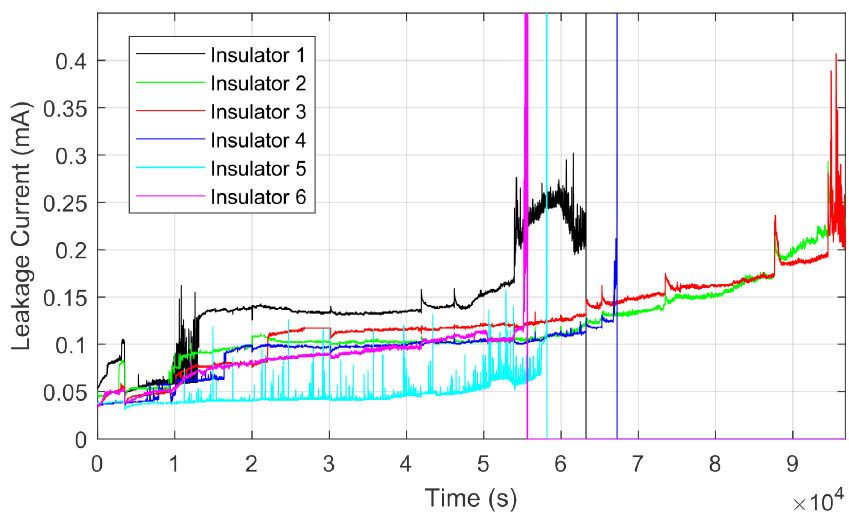
Figure 2. Leakage current of the contaminated